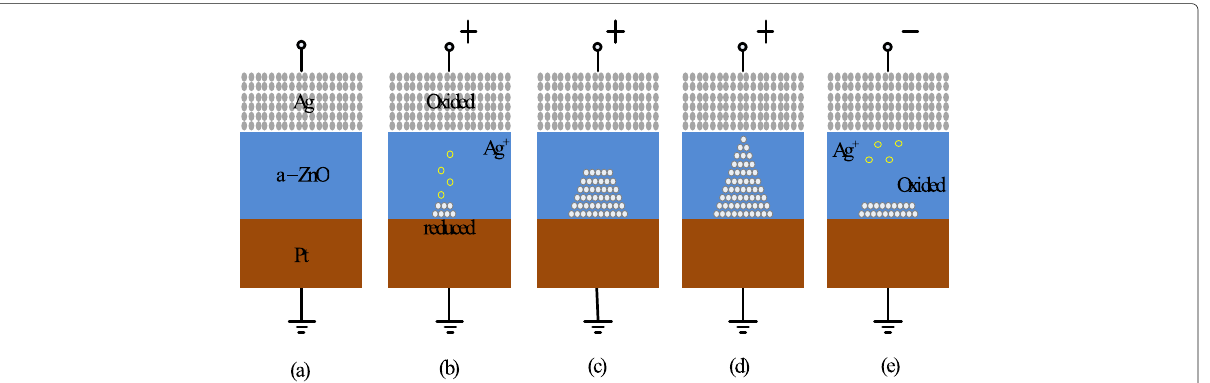
Fig. 5 Schematic of the switching mechanism of conductive bridge RRAM. a Pristine state of the RRAM device. b , c Oxidation of Ag and migration of Ag + cations towards cathode and their reduction. d Accumulation of Ag atoms and Pt electrode leads to growth of highly conductive filament. e Filament dissolution takes place on applying voltage of opposite polarity